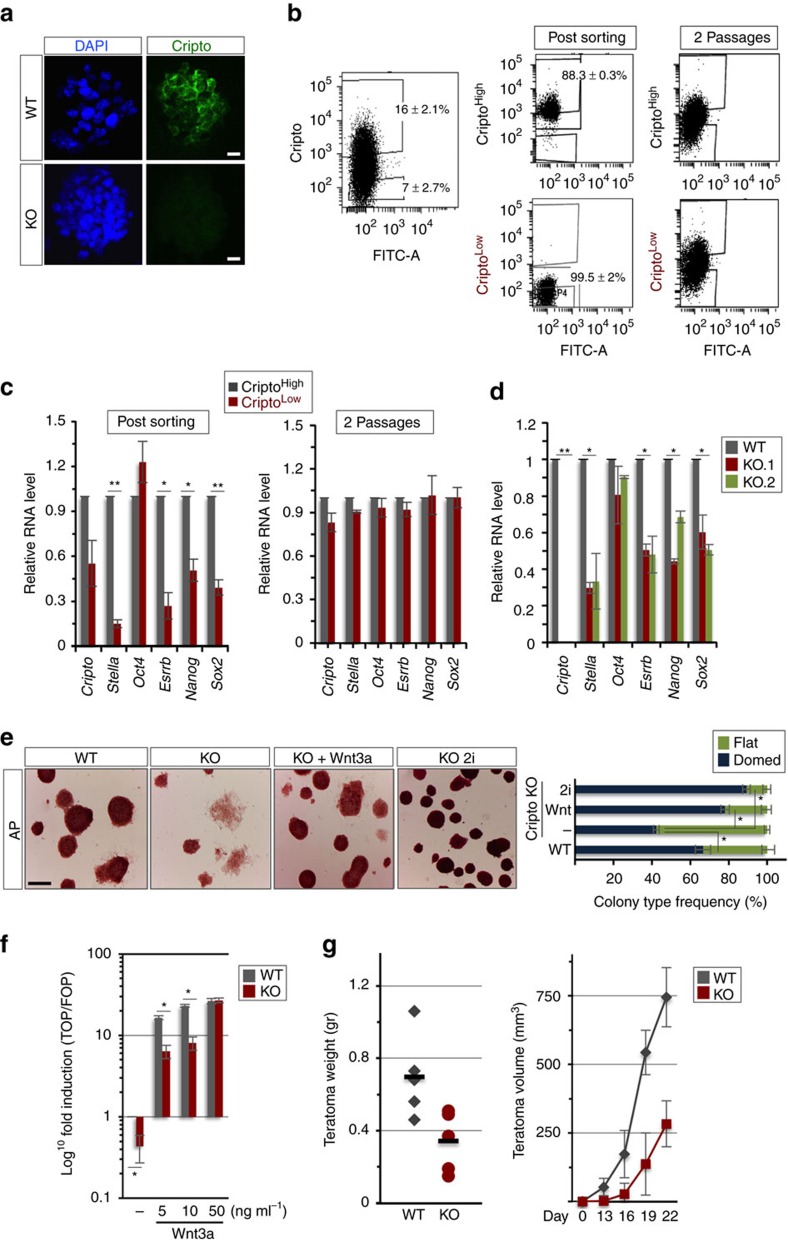
Cripto sustains mESC self-renewal by modulating canonical Wnt signalling.(a) Immunofluorescence of Cripto on non-permeabilized WT and Cripto KO ESCs. Nuclei were stained with 4,6-diamidino-2-phenylindole (DAPI). Scale bar, 75 μm. (b) FACS-based separation of CriptoHigh and CriptoLow in serum/LIF mESCs. Data are mean±s.e.m. (n= 3). (c) qPCR of Cripto and pluripotency genes' expression on CriptoHigh and CriptoLow cells immediately after sorting and after two passages in culture. Relative RNA level was normalized to Gapdh; data are mean±s.e.m. (n=3; *P<0.01 and **P<0.005). (d) qPCR of pluripotency genes' expression in WT and two independent Cripto KO ESC clones (KO.1 and KO.2) in serum/LIF culture conditions. Relative RNA level was normalized to Gapdh; data are mean±s.e.m. (n=3; *P<0.01 and **P<0.005). (e) Representative pictures (scale bar, 100 μm) of AP- stained and colony-type frequency (domed versus flat) of colonies generated from WT, Cripto KO, KO+Wnt3a (50 ng ml−1) and KO 2i ESCs, at day 6 after plating (∼100 colonies scored per condition). (f) TOP flash reporter activation in WT and Cripto KO ESCs in baseline conditions and following Wnt3a stimulation at indicated concentrations. Data are mean±s.e.m. (n=3); *P<0.01. (g) Effect of Cripto depletion on teratomas formation. Quantitative analysis of tissue weights (left panel) and temporal kinetic analysis (right panel) of teratomas growth (volume, mm3). Data are mean±s.e.m. (five mice per group).